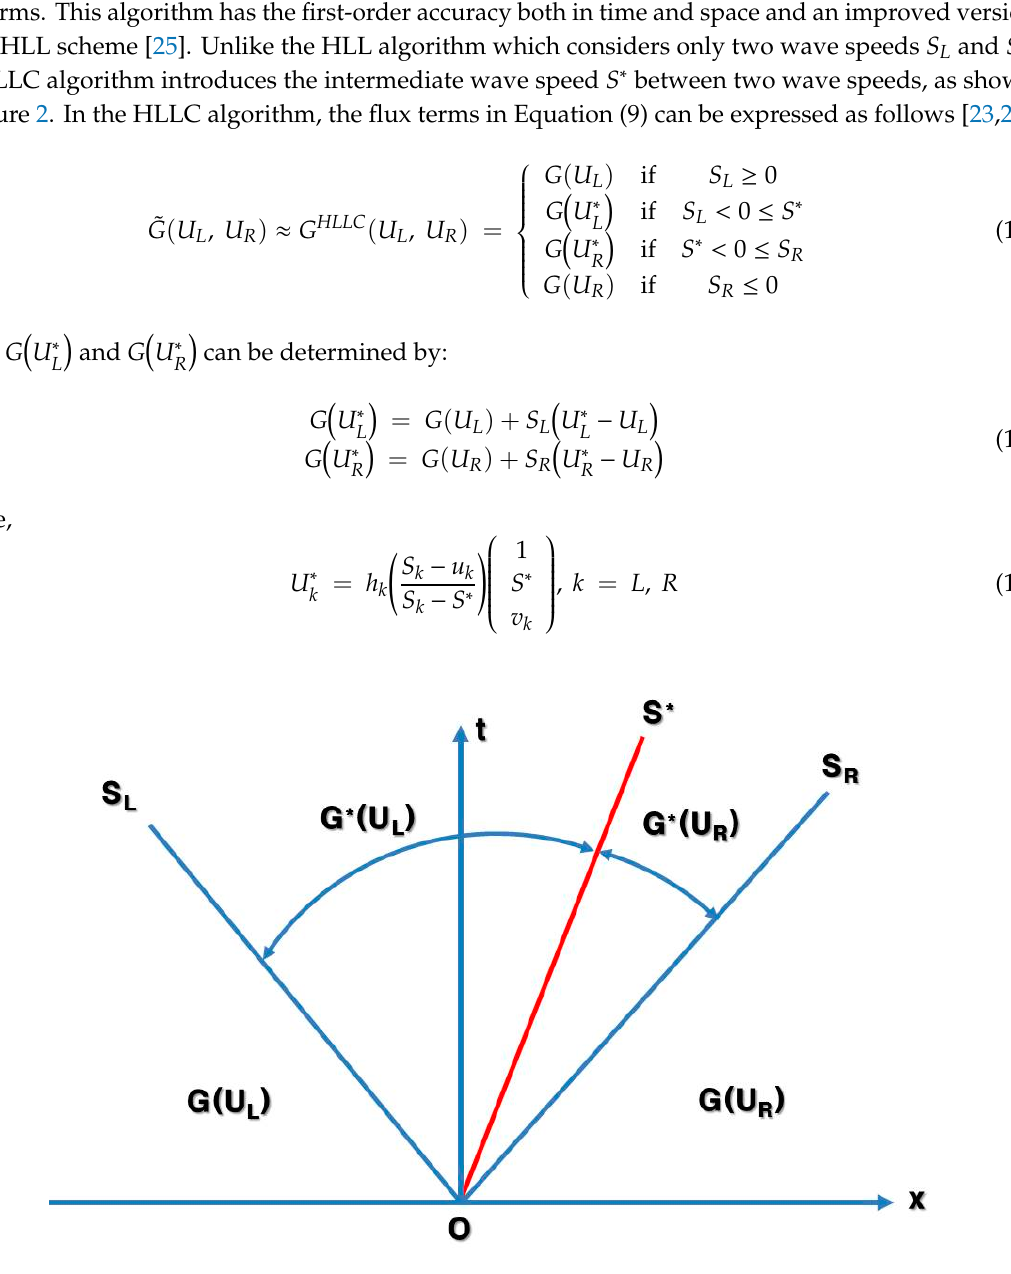
Figure 2. Schematic illustration of Harten–Lax–Van Leer contact (HLLC) flux approximation.